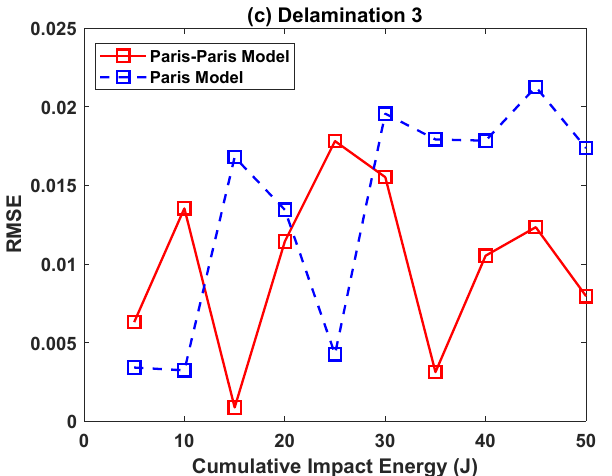
Figure 5. Comparison plot for root mean square error values between the Paris model and Paris– Paris model for all the three delamination of Sample S1.